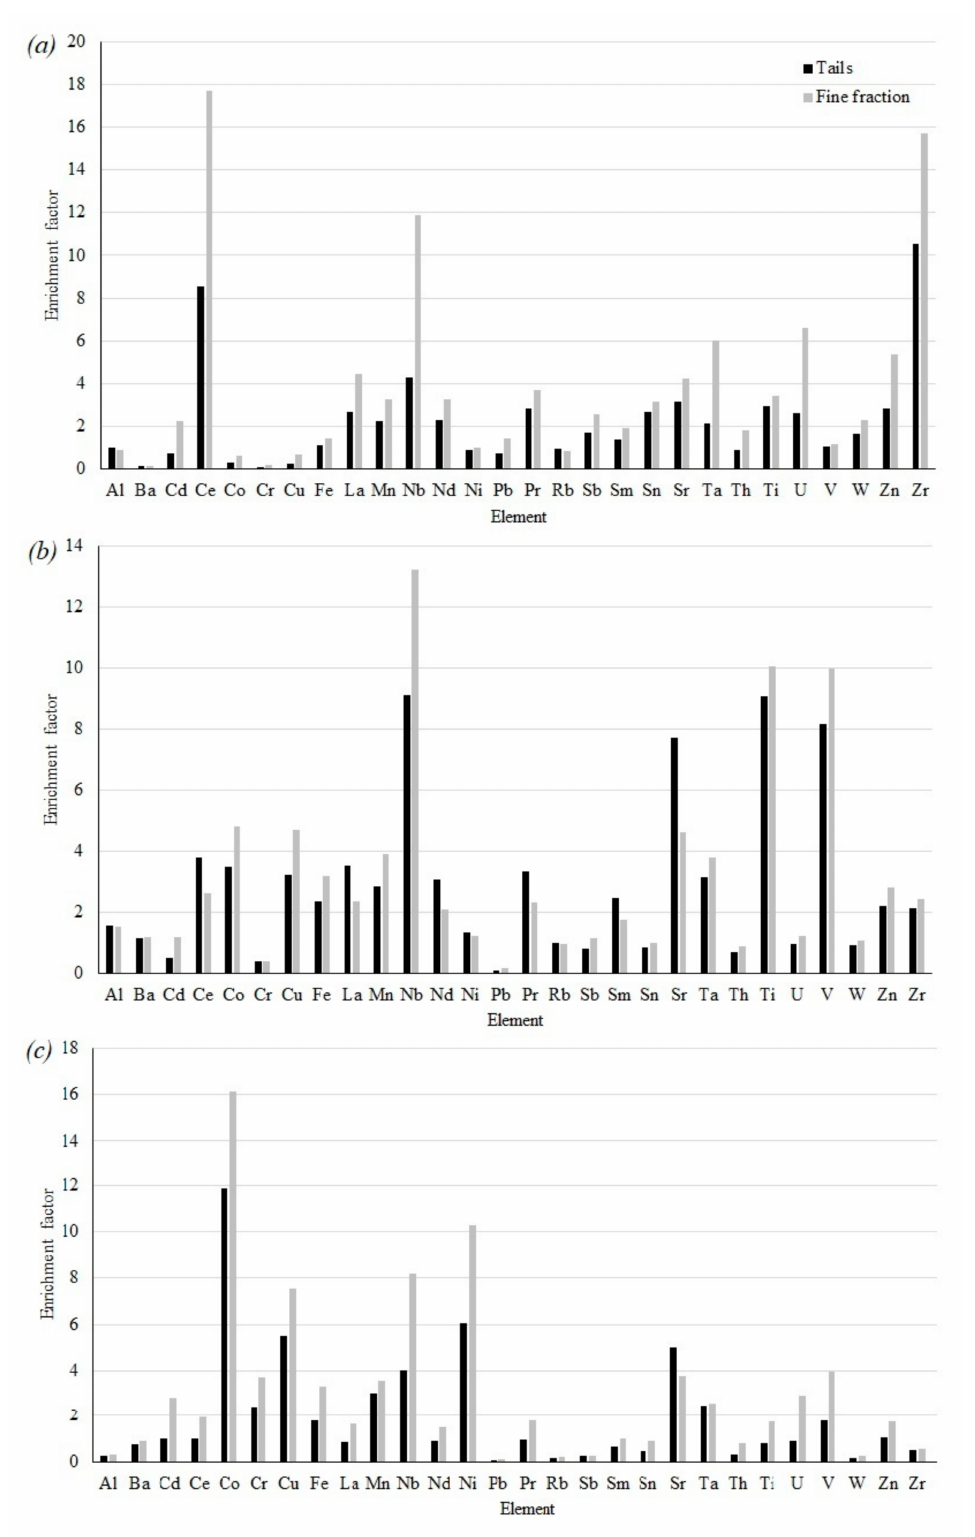
Figure 3. Enrichment factors: ( a )—loparite ore dressing tails, ( b )—apatite-nepheline ore dressing tails, ( c )—complex ore dressing